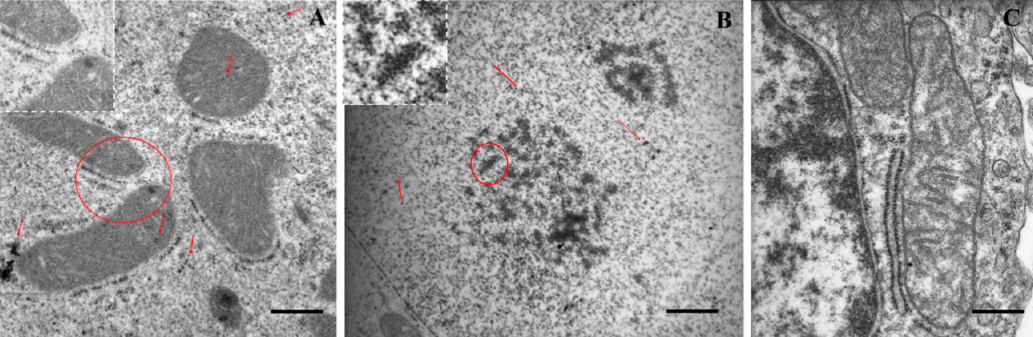
Figure 5. TEM micrographs of ( A , B ) LoVo cellular uptake of FA ‐ PEG@MNP after 72 h of incubation, ( C ) control cells. A group of mitochondria (A) and the surrounding cytoplasm contain MNPs (red arrows). In the nucleus FA ‐ PEG@MNP spreads between chromatin (red arrows). The magnified images (white dotted frame) of the area indicated by red circles. Scale bar: A = 0.6 μ m, inset: 1.4×; B = 0.7 μ m, inset 2.5×; C = 0.6 μ m.